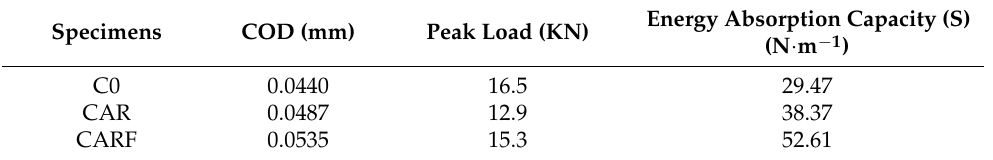
Table 3. Characteristic parameters of